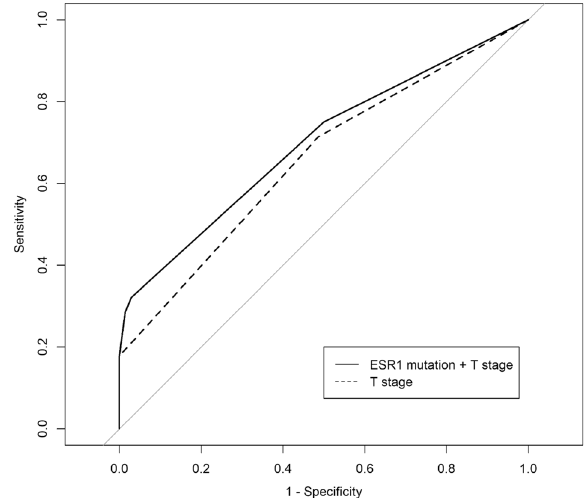
Fig. 6 The areas under the curve (AUC) of two models. The AUC of the model with an ESR1 mutation and T stage was numerically higher than that of the model with T stage alone. The AUCs of the two models were 0.698 (95% CI, 0.583 – 0.812) and 0.658 (95% CI, 0.545 – 0.770), respectively. There was no statistical difference when using the DeLong